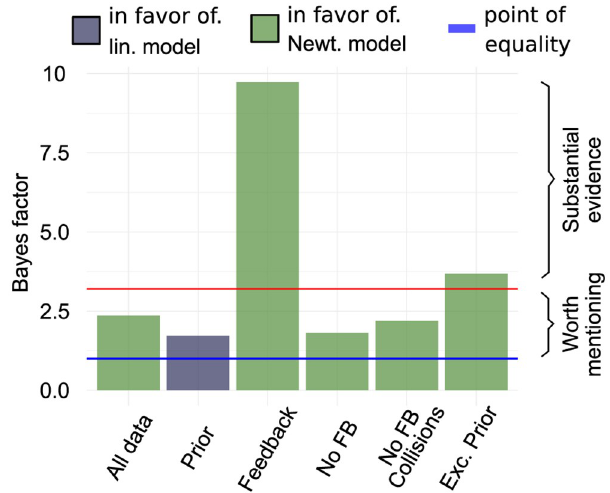
Fig 7. Bayes factors calculated from posterior odds sampled using the product space method. Bayes factors are displayed for different phases and combinations of phases. Blue line at 1 marks the point where neither model is stronger supported by evidence. Red line at 3.2 marks the transition from Bayes factors being only worth mentioning to substantial evidence in favor of one the models. Colors of bars indicate the model favored by the Bayes